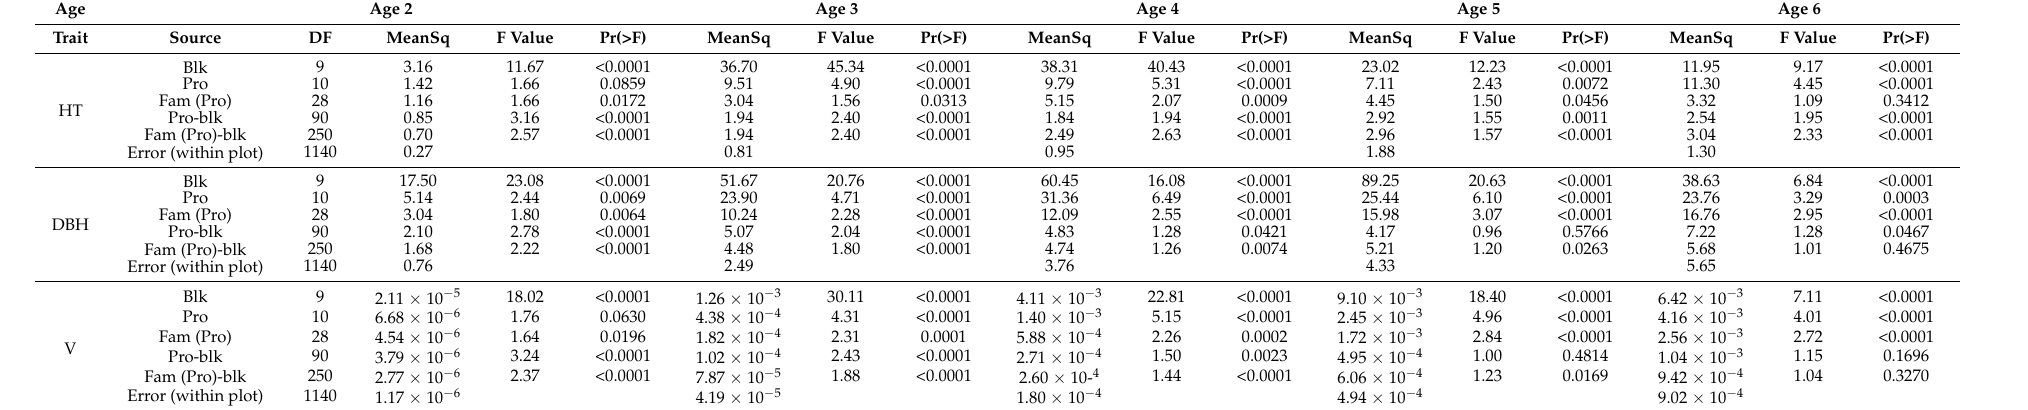
Table 3. Variance analysis of each trait in a linear mixed effect